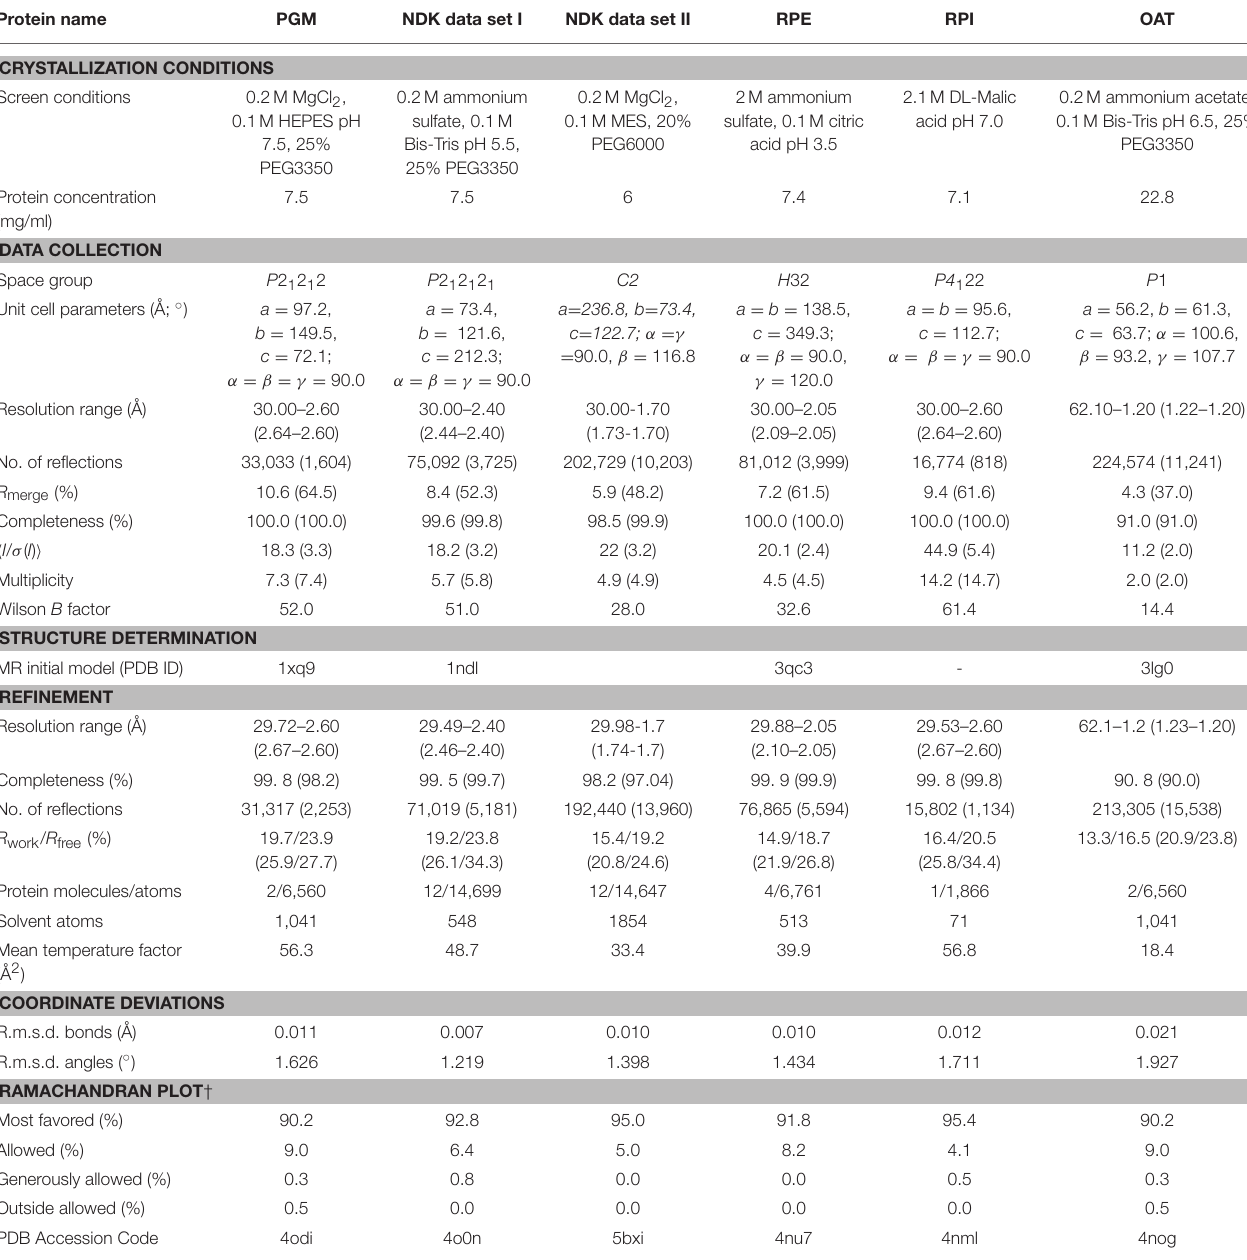
TABLE 2 | Crystallization conditions, data-collection, structure determination and refinement statistics of T. gondii